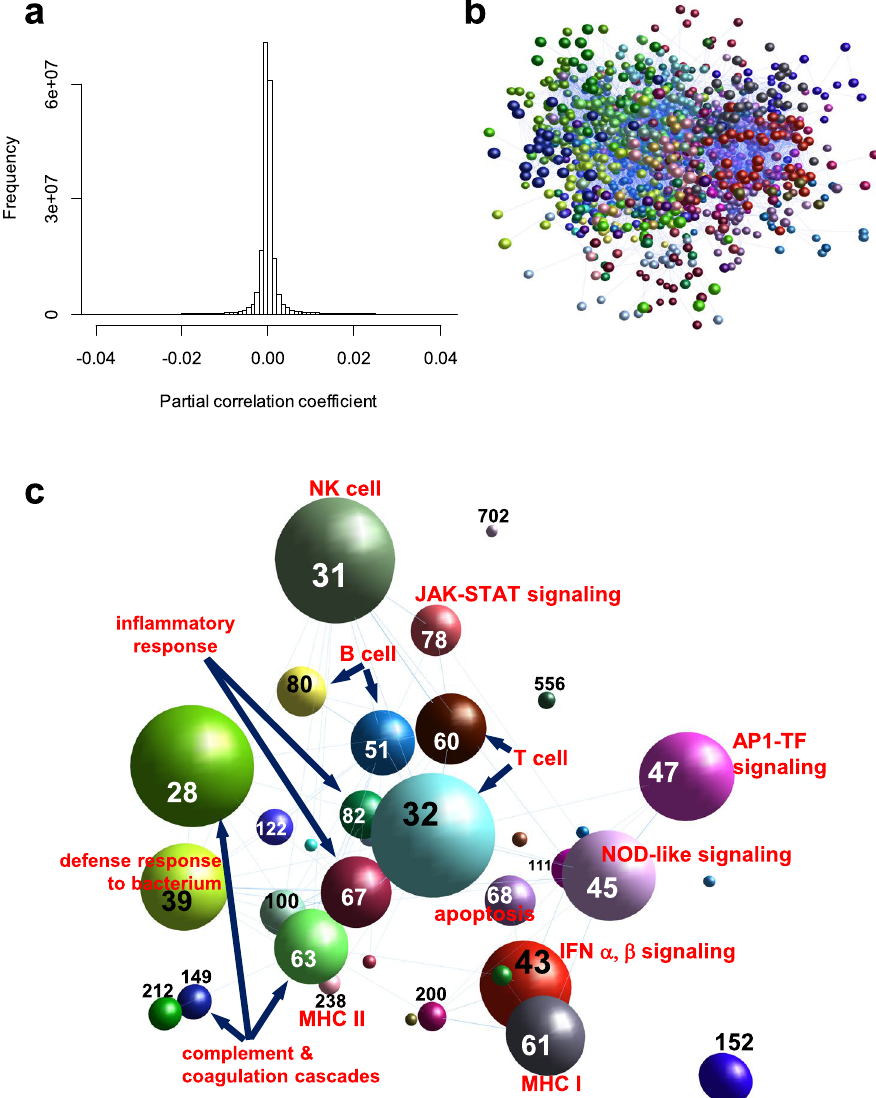
Figure 1. Characterization of the human co-expression network. ( a ) Histogram showing the distribution of the partial correlation coefficient ( pcor ) between gene pairs. Most gene pairs show pcors between -0.02 and 0.02. ( b ) A sub-network for immunity-related modules extracted from the entire gene co-expression network. In the network, each sphere represents a gene, and connection between genes indicates their similar expression pattern. Genes are colored according to their module identities. ( c ) A simplified version of the sub-network from B is shown. The genes from the same module are represented by a single sphere. The size of the sphere is proportional to the number of genes within a module. The number shown within the module sphere represents module # shown in Supplementary Dataset 1. The network is shown in a 3-D space layout and some modules (e.g. #477 and #851) are hidden behind modules in